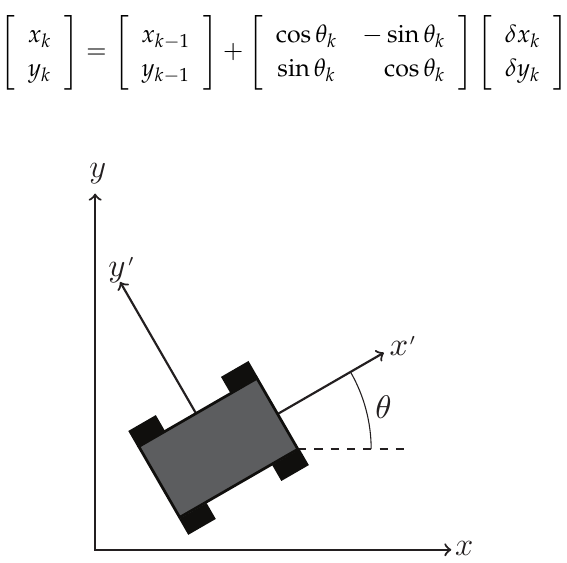
Figure 19. Overview of the visual odometry